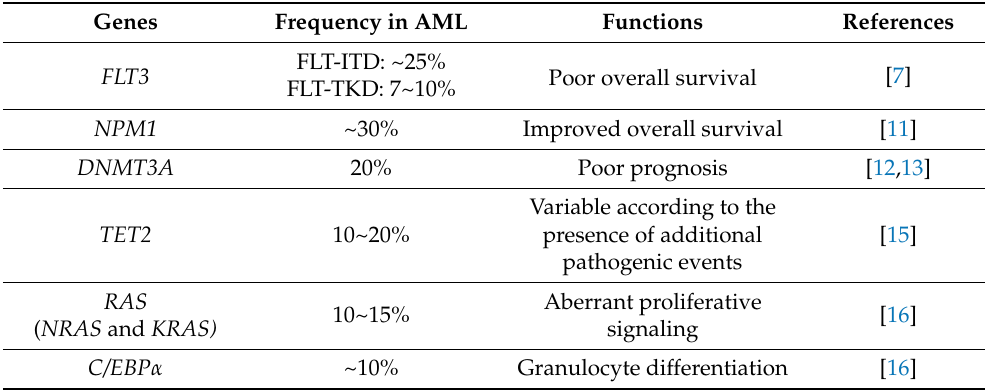
Table 1. Common gene mutations in